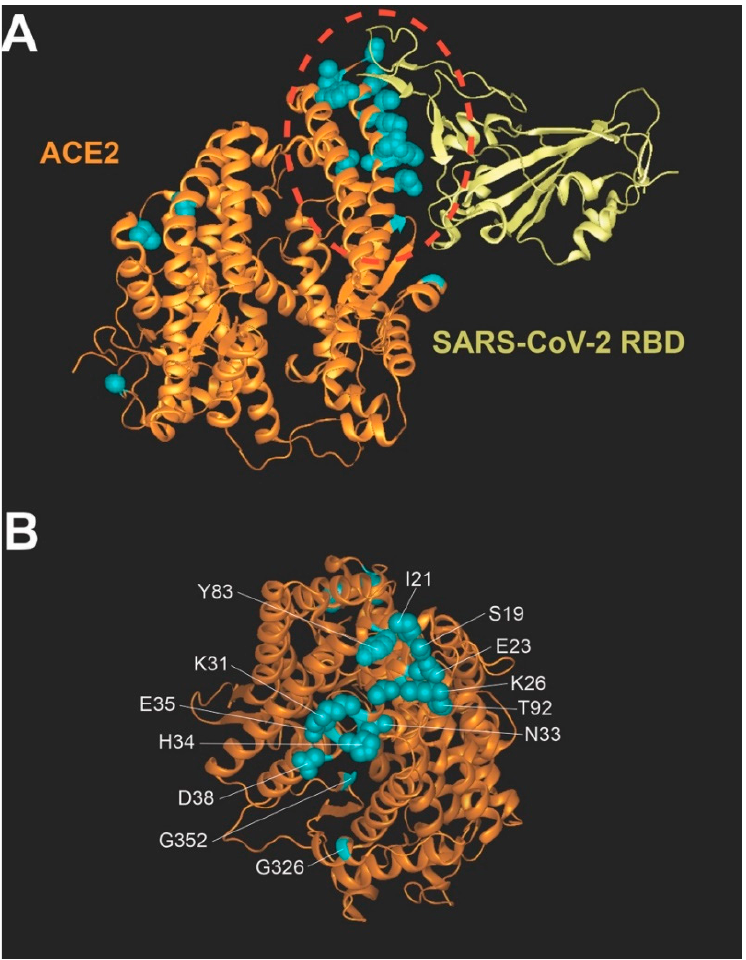
Figure 1. Localization of polymorphisms in the human ACE2 structure. ( A ) The structure of the hACE2 receptor (orange) in complex with the receptor-binding domain (RBD) of the SARS-CoV-2 spike (yellow) (6m0j). The interface between human ACE2 and the spike protein is circled in red, and the location of hACE2 polymorphisms are shown in cyan. ( B ) hACE2 residues at the interface between ACE2 and the spike are shown, forming a cluster in the center of the structure. hACE2 polymorphisms are shown in